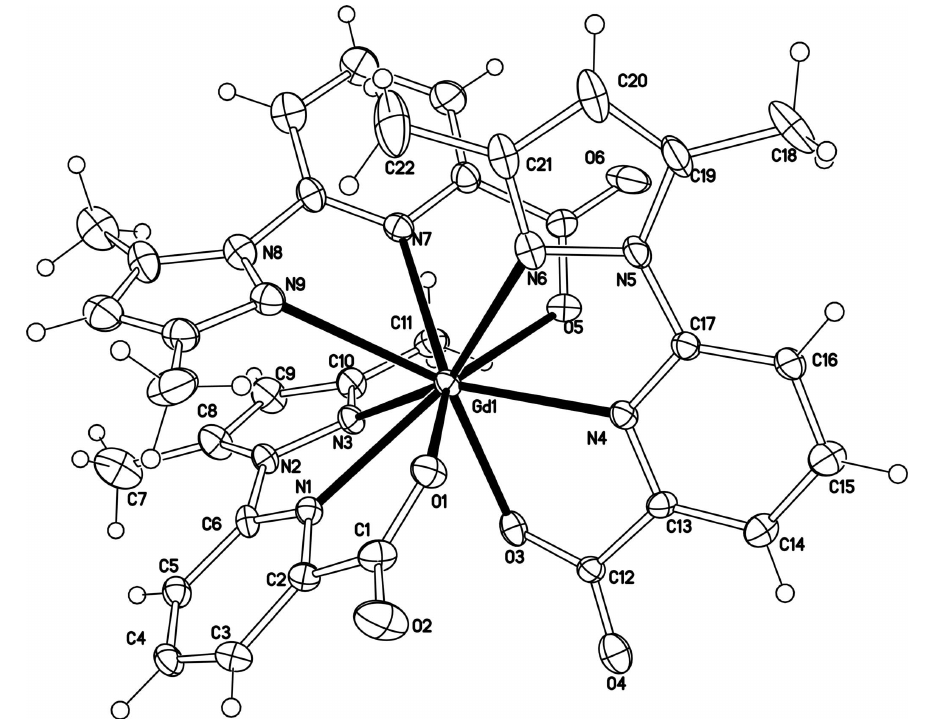
The structure of the title compound showing 50% probability displacement ellipsoids and the atom-numbering scheme. All of the solvate sites contain atoms that were refined at half